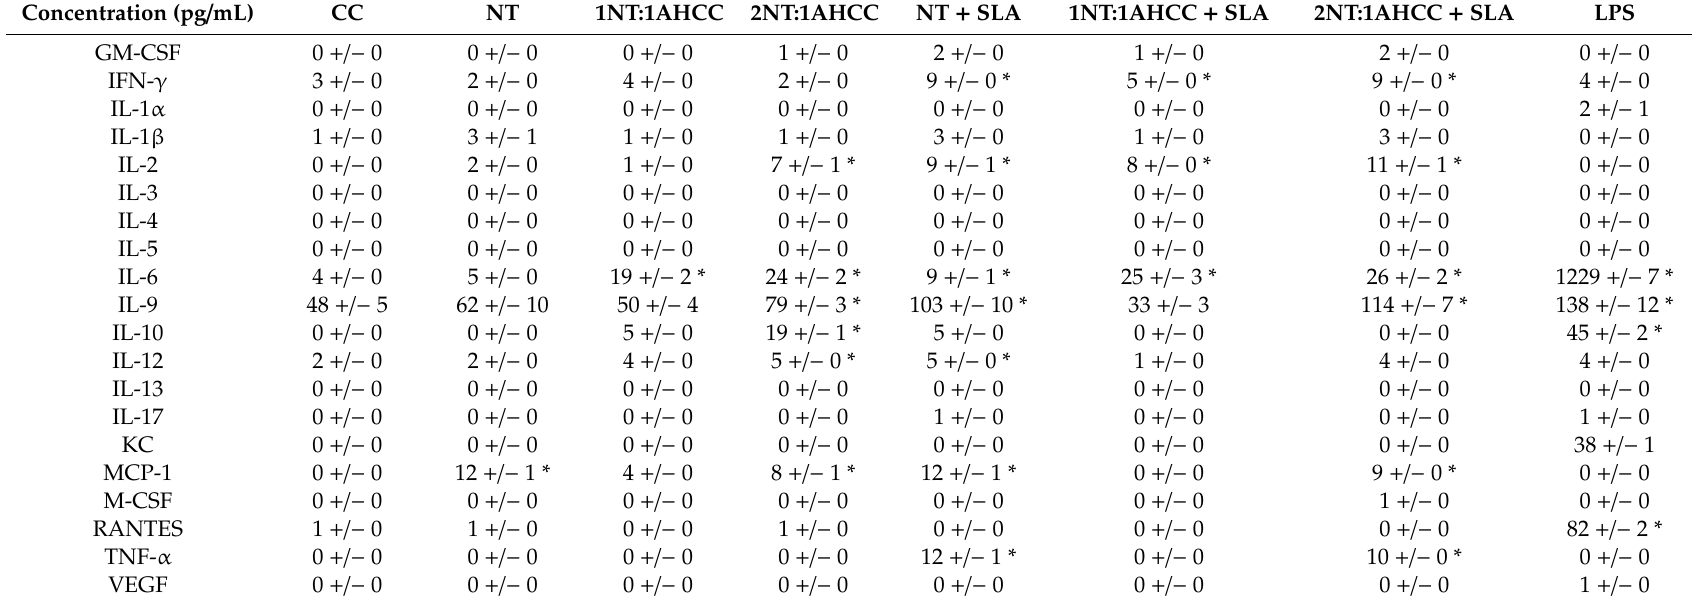
Table 1. Cytokine quantification after exposure to nucleotides (NTs), AHCC, and their combinations in lymphocyte culture with or without SLA stimulation. Each value represents the mean +/ − standard deviation for three replicates. * p < 0.05 versus the control. Concentration (pg /